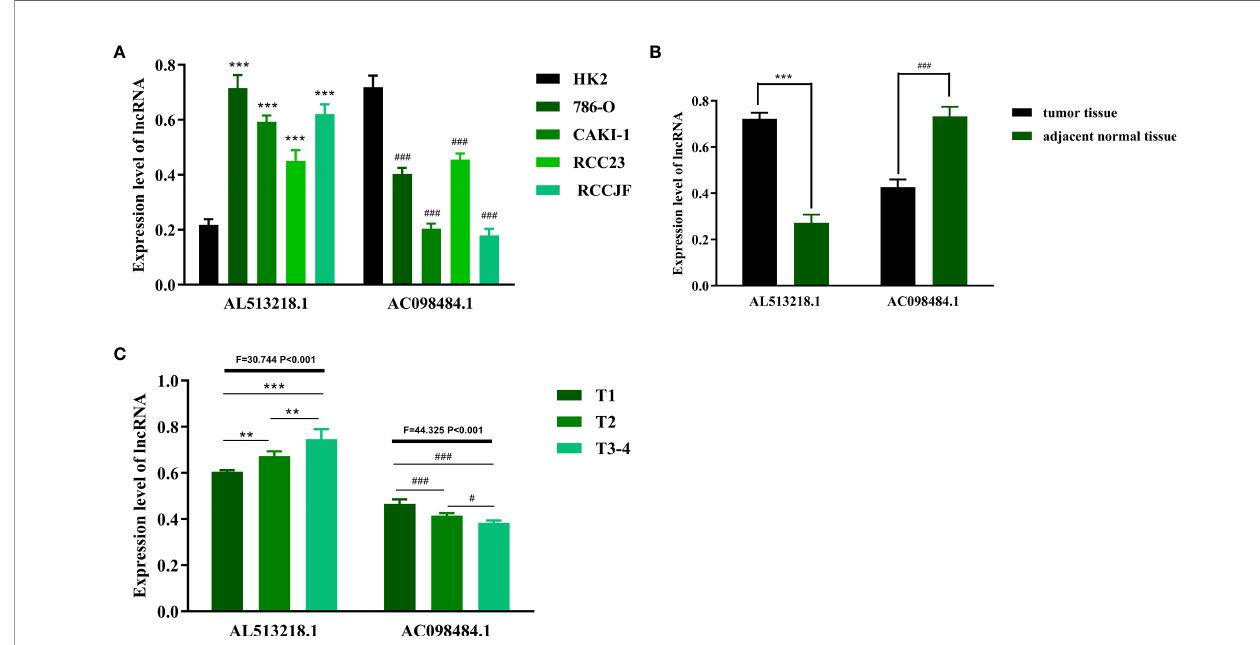
FIGURE 9 | The expression levels of AL513218.1 and AC098484.1 in vitro and in vivo. The expression levels of AL513218.1 and AC098484.1 in renal cancer cell lines and renal tubular epithelial cell were measured by RT-qPCR (A) . *** and ### represent the signi fi cant difference compared with HK2 (P < 0.001). The RT-qPCR results of AL513218.1 and AC098484.1 in carcinoma tissues and adjacent normal tissues (B) . *** and ### represent the obvious difference compared with adjacent normal tissues (P < 0.001). The expression levels of AL513218.1 and AC098484.1 in various ccRCC tissues with different T-stages (C) . ***, **, ### and # represent the remarkable difference compared with another group (P < 0.001, P < 0.01, P < 0.001 and P < 0.05),